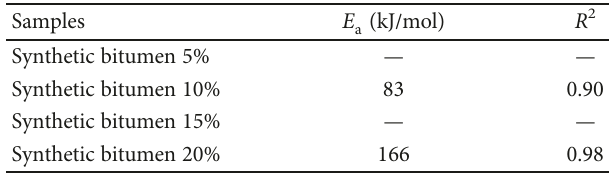
Table 2: Parameters for the Arrhenius model.